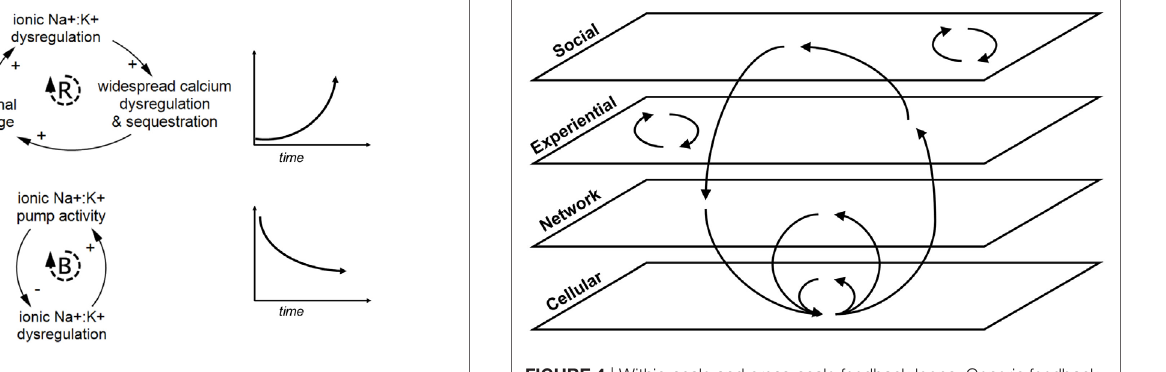
FigUre 3 | Examples of reinforcing and balancing feedback. Panel (a) shows a reinforcing feedback loop and a corresponding graph of exponentially increasing behavior over time. Panel (B) shows a balancing feedback loop and a corresponding graph of decreasing behavior over time toward an internal set point, based on ionic pump activity attenuating ionic dysregulation. Reinforcing and balancing feedback are the two types of feedback loops found in complex